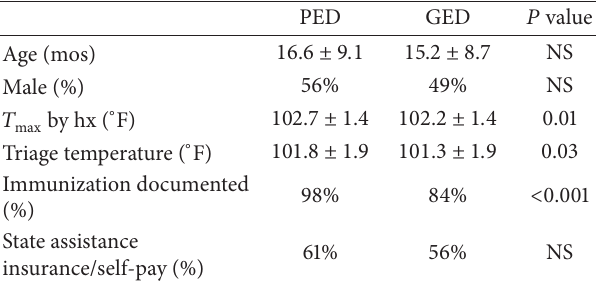
Table 1: Demographics.